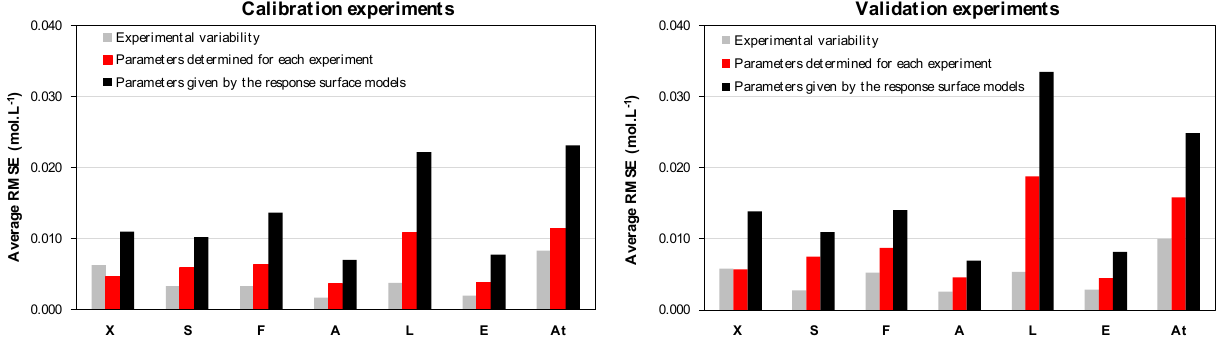
Figure 7. Comparison between experimental variability and average RMSE values for concentrations computed using parameters determined for each experiment (Table 2) and the response surface models (Table A2 and Equation (17)).